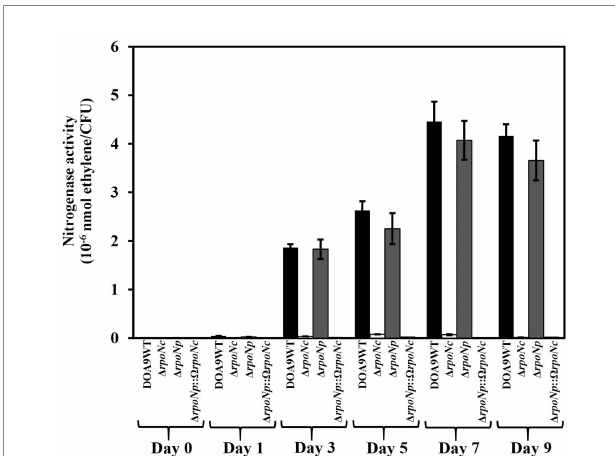
FIGURE 4 Nitrogenase enzyme activity of Bradyrhizobium sp. DOA9WT, DOA9 Δ rpoNc , DOA9 Δ rpoNp and DOA9 Δ rpoNp :: Ω rpoNc strains under free-living conditions. Bacterial strains were grown in BNM-B medium without N source under microaerobic conditions and at different days after inoculation the nitrogenase enzyme activity was determined using the acetylene reduction assay (ARA). For each time-point the number of living cells in the culture was determined and the nitrogenase enzyme activity was expressed as nmol ethylene/colony forming units (CFU) of the culture. Data sets represent mean values of three replications, and statistically significant differences [ANOVA Tukey test ( p < 0.01)] are